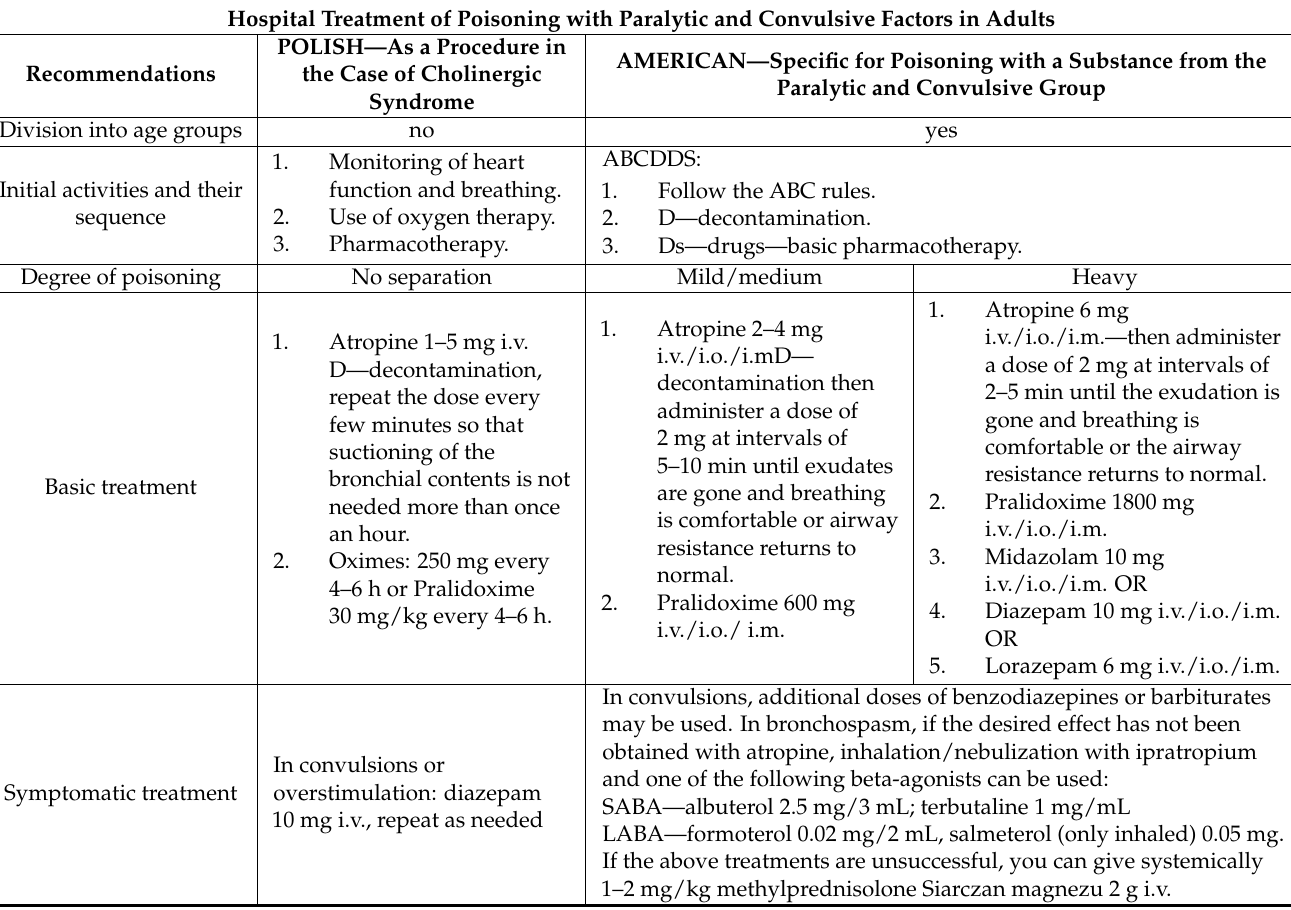
Table 5. Comparison of Polish and American standards in the treatment of poisoning with paralytic and convulsive factors in adults